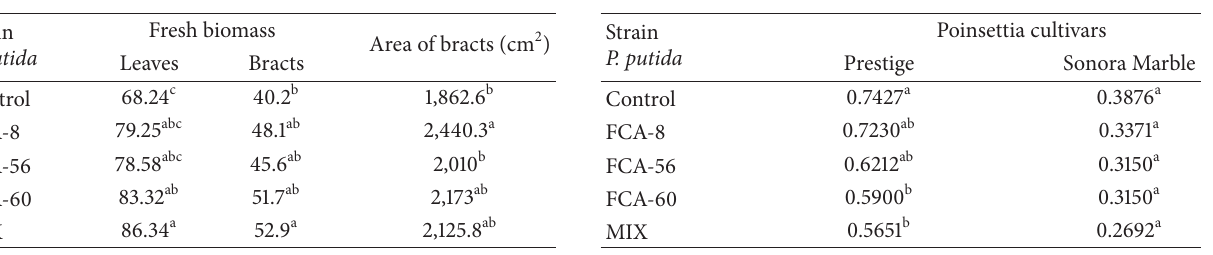
Table 2: Effects of Pseudomonas putida strains on growth promo- tion of poinsettia Prestige cultivar.